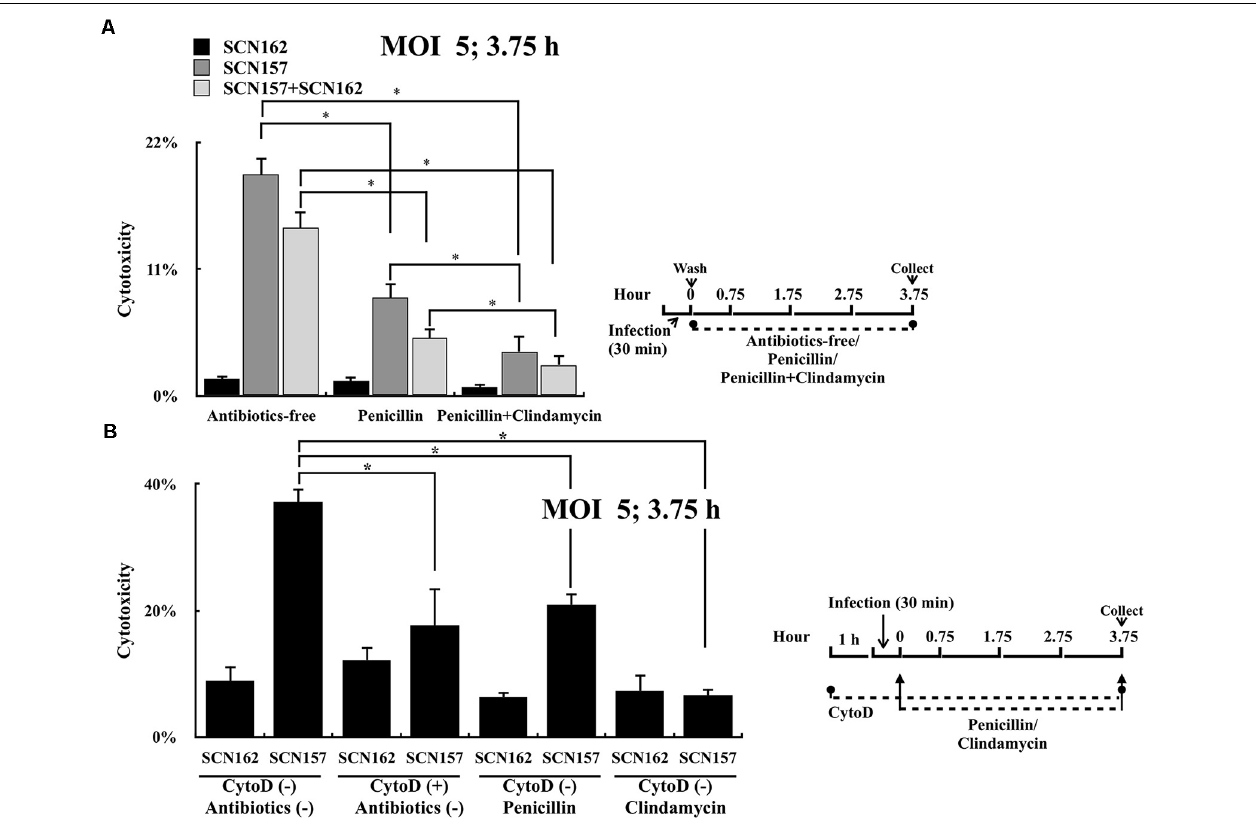
FIGURE 5 | Cytotoxicity of the capsule-deficient A20 (SCN162) and AP3 (SCN157) on PMA-activated U937 cells with or without penicillin, clindamycin, and cytochalasin D treatment after infection. (A) Cytotoxicity of SCN162 and SCN157 on PMA-activated U937 cells with or without antibiotic treatment after 3.75 h of infection. (B) Cytotoxicity of SCN162 and SCN157 on PMA-activated U937 cells with or without cytochalasin D or antibiotic treatments after 3.75 h of infection. The right panels of (A,B) show the infection protocols. Error bars represent the standard deviations. ∗ p < 0.05.